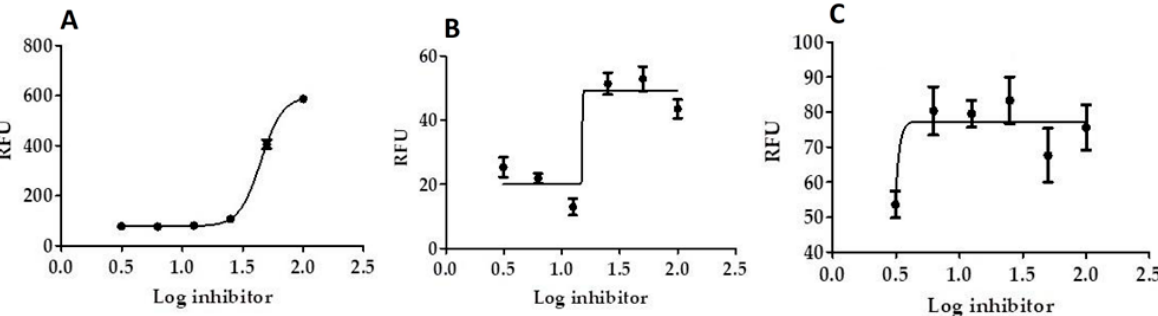
Figure 7. Inhibition of 3CL protease enzyme activity by SIT ( A ), GA ( B ), and ( C ) SIT-GA nano-conjugates. RFU = relative fluorescence units.